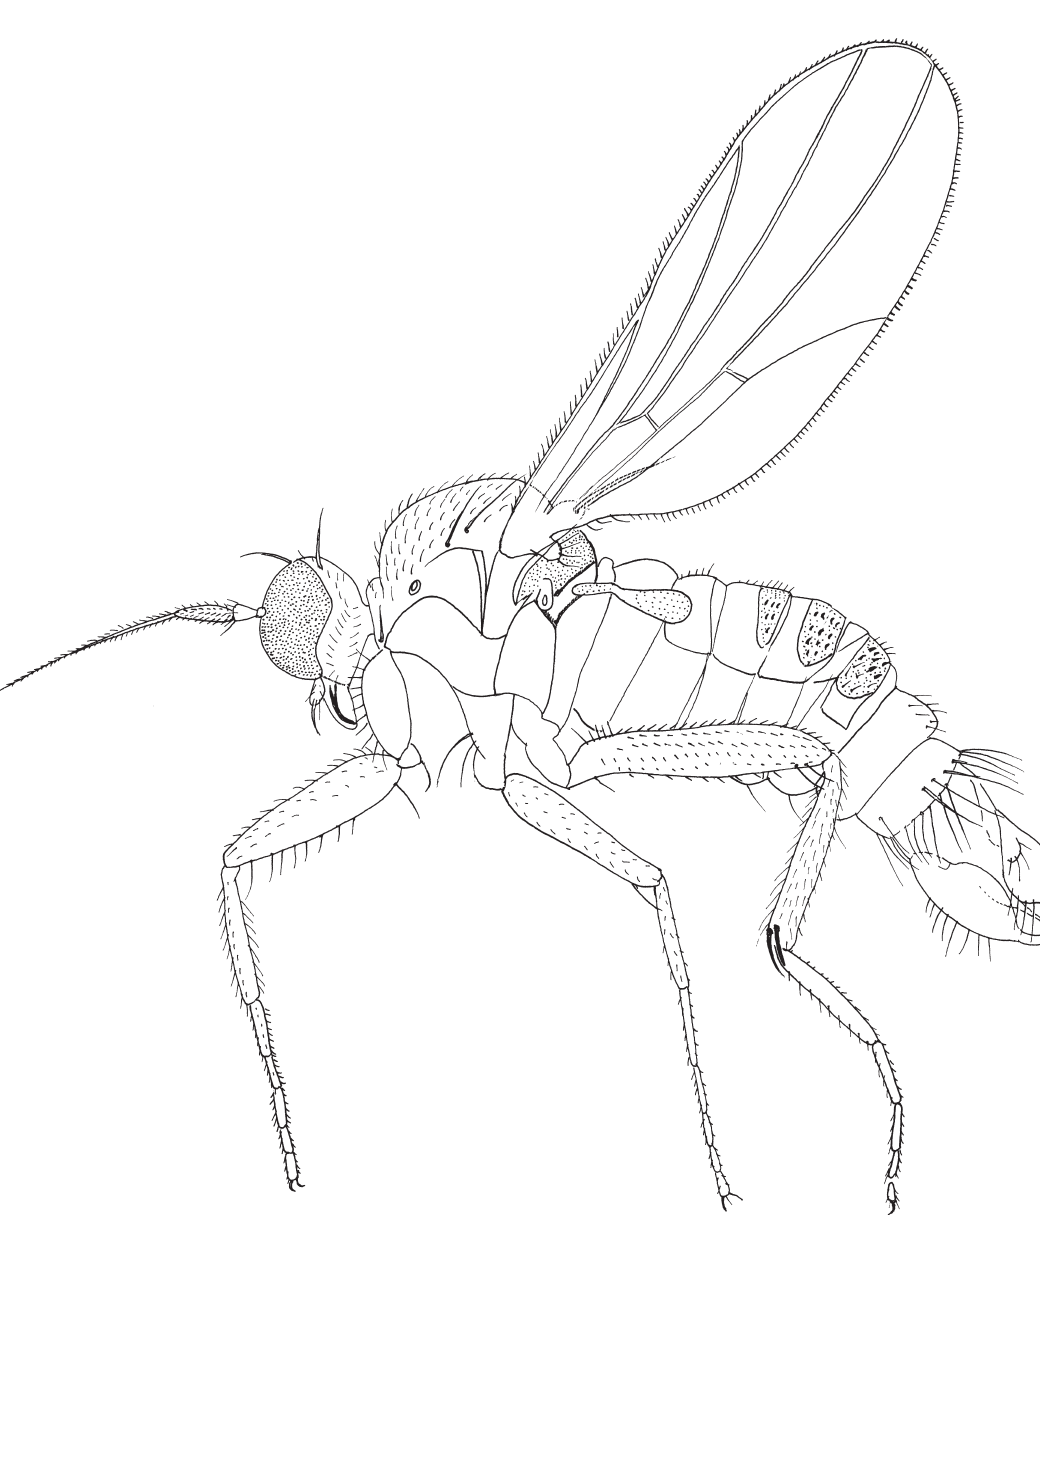
Fig. 108. Elaphropeza biuncinata (Melander, 1928), ♂, habitus. (after Shamshev & Grootaert